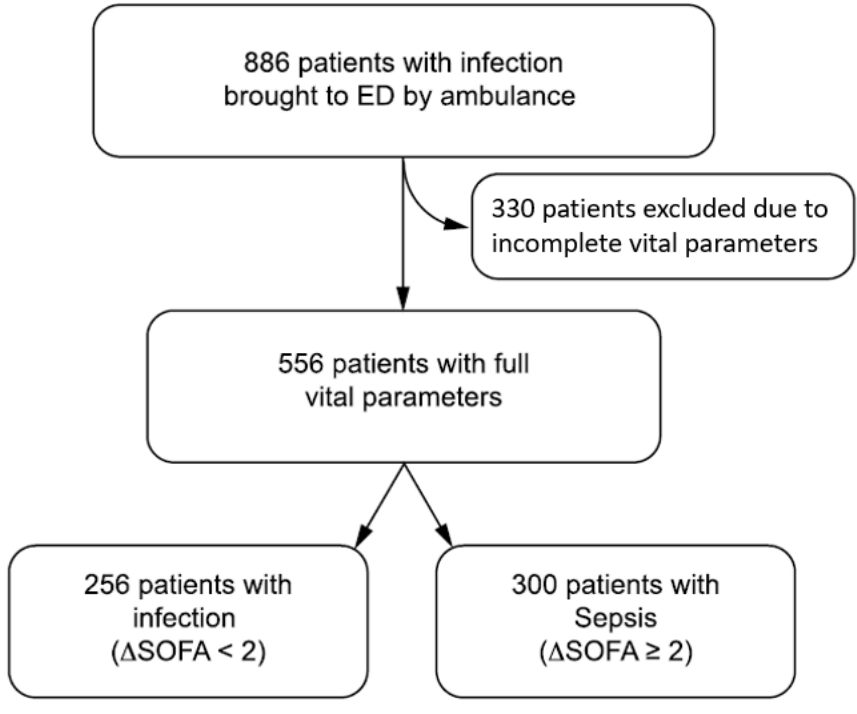
Figure 1. Study Figure 1. Study flowchart.